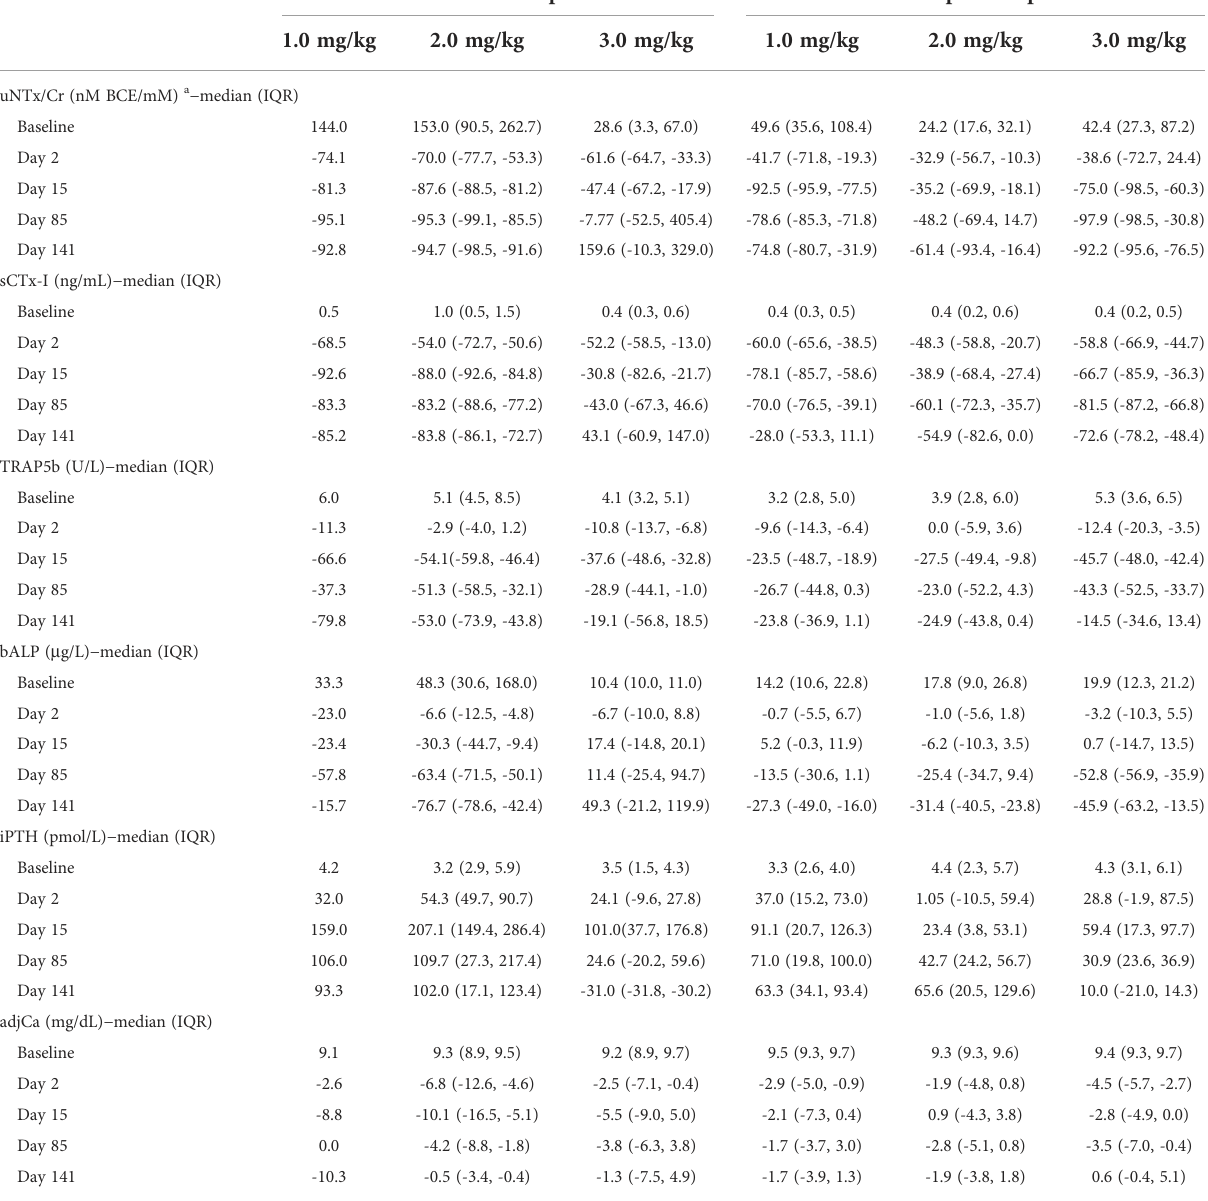
TABLE 6 Median percentage changes from baseline in bone turnover biomarkers in the PDAS. Bone turnover